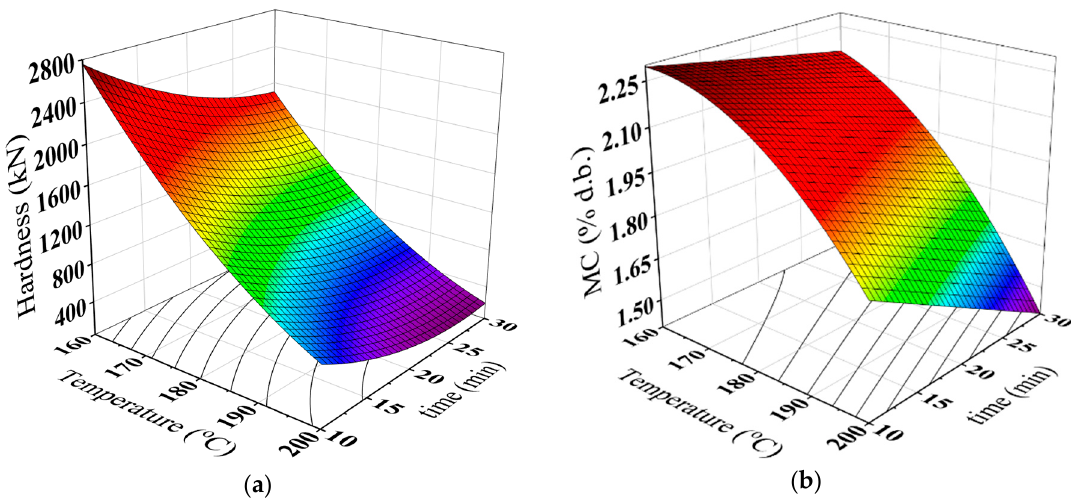
Figure 2. Three-dimensional surface plots for ( a ) hardness of whole seeds, ( b ) moisture content of the full fat roasted date seeds powder.